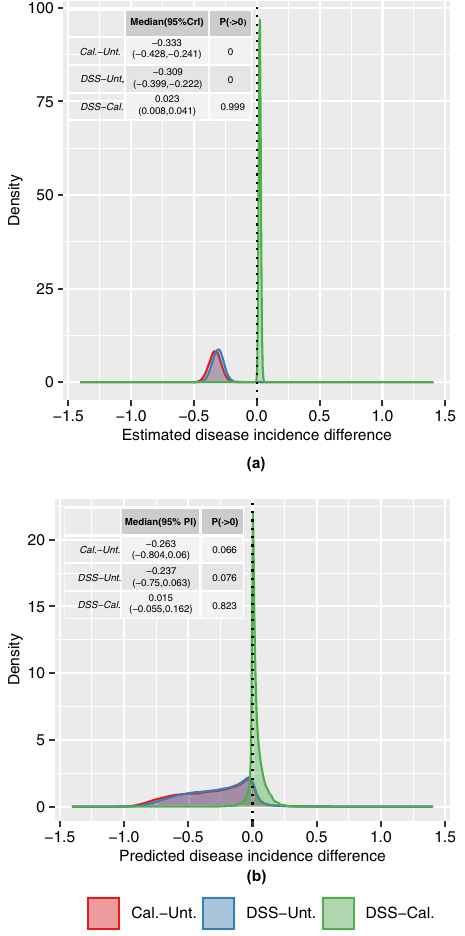
Fig. 2 Probability distributions of differences in disease incidence between calendar-based strategies (Cal), DSS-based strategies (DSS) and untreated controls (Unt). Differences were computed for Cal vs. Unt (Cal-Unt), DSS vs. Unt (DSS-Unt) and DSS vs. Cal (DSS-Cal) strategies. While ( a ) describes the distributions of the expected differences across the experiments included in the dataset, ( b ) describes the plausible difference values predicted for a new, not yet conducted, experiment. Both types of the probability distribution are summarised by their medians, 95% probability intervals and probability of the differences being positive. CrI and PI mean credibility and predictive intervals, respectively. P (>0) indicates the probabilities of the differences being positive. Results show that the levels of reduction in disease incidence achieved with DSS and Cal compared to Unt are very similar (median reductions of − 33 and − 31% with Cal and DSS, respectively), although the reduction is slightly higher with